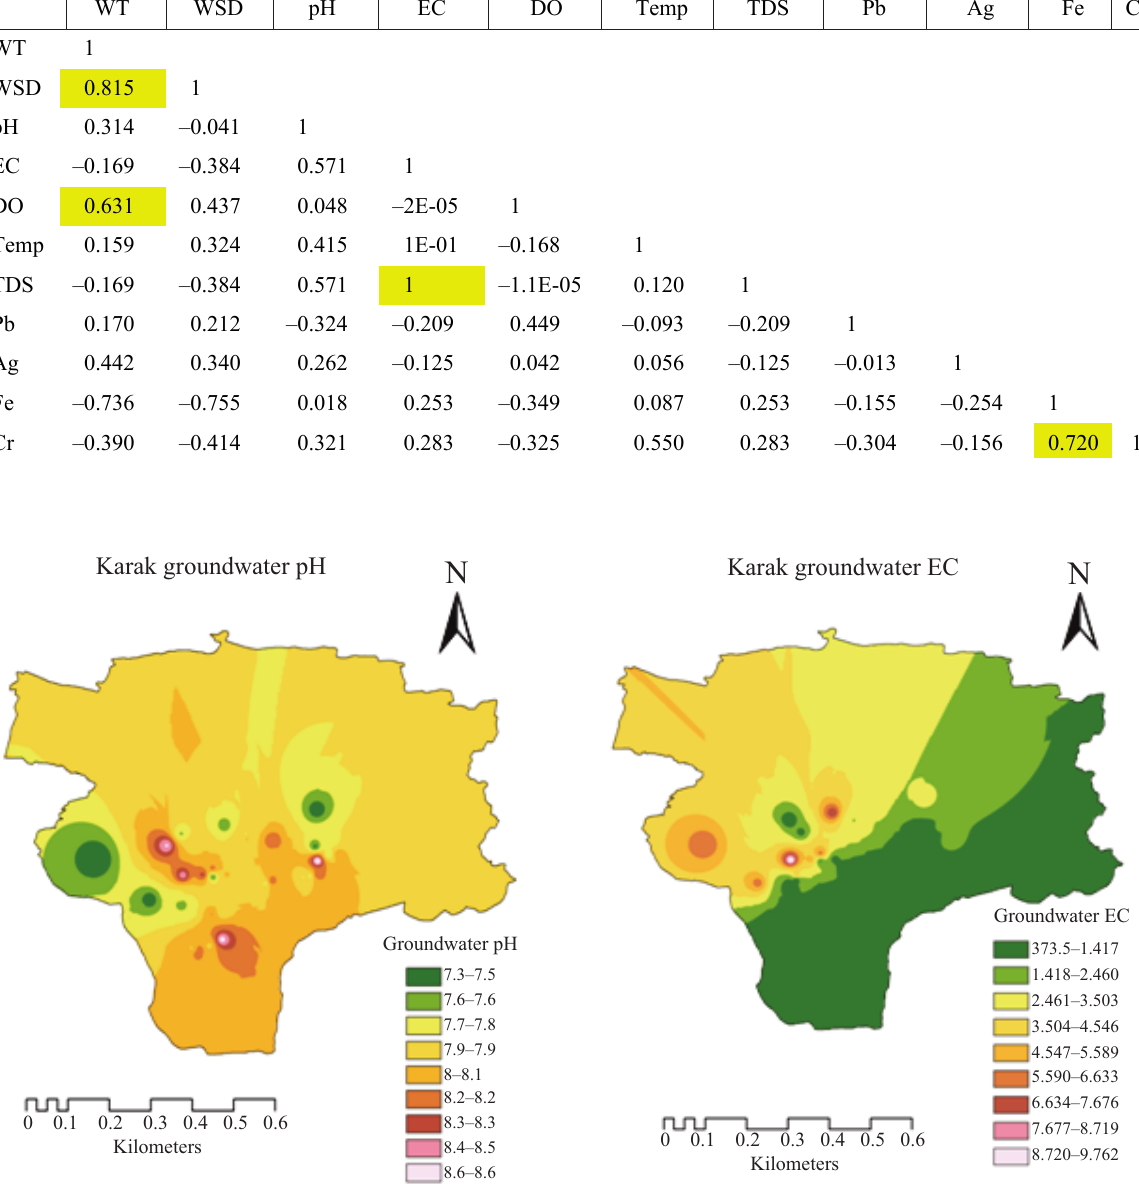
Fig. 3. The pH content and electrical conductivity (EC) of groundwater in μS/cm in different